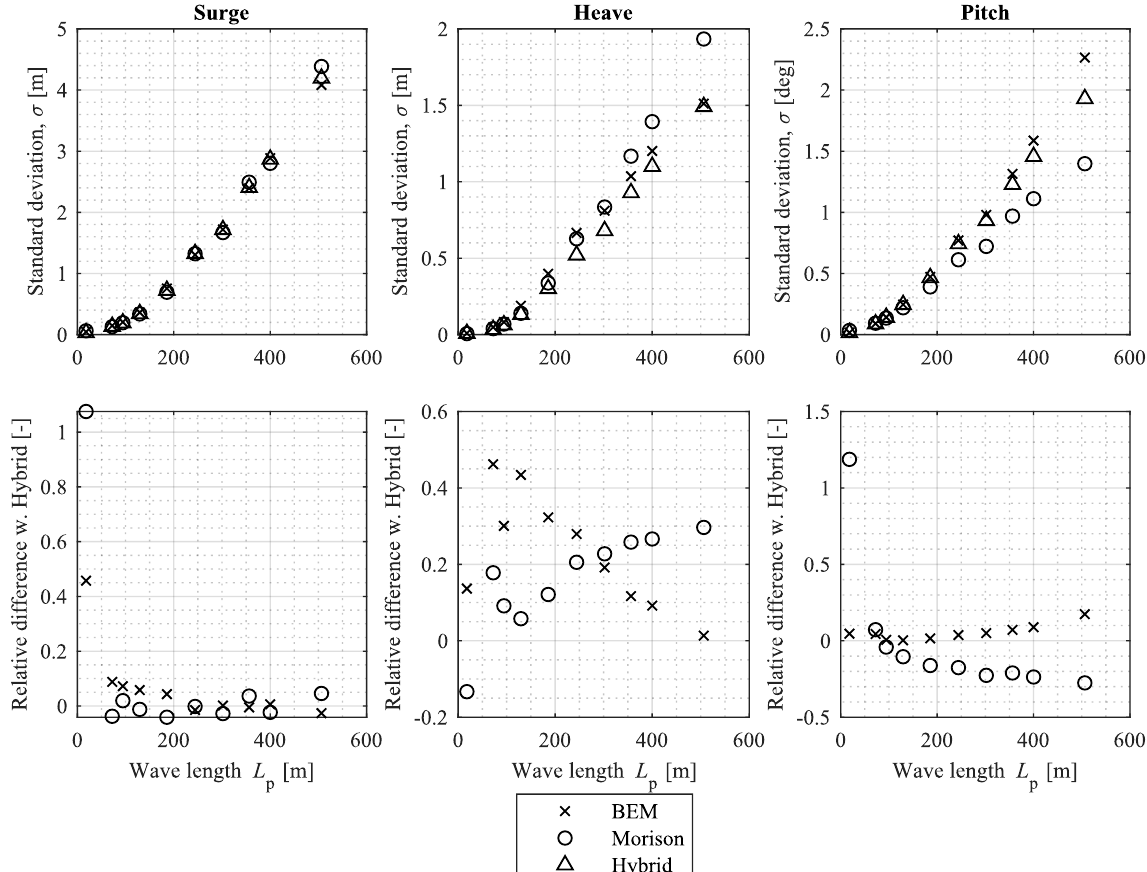
Figure 5. Top: Standard deviation, σ of the surge ( left ), heave ( middle ) and pitch ( right ) DoF. The bottom figures illustrates the relative difference with the hybrid